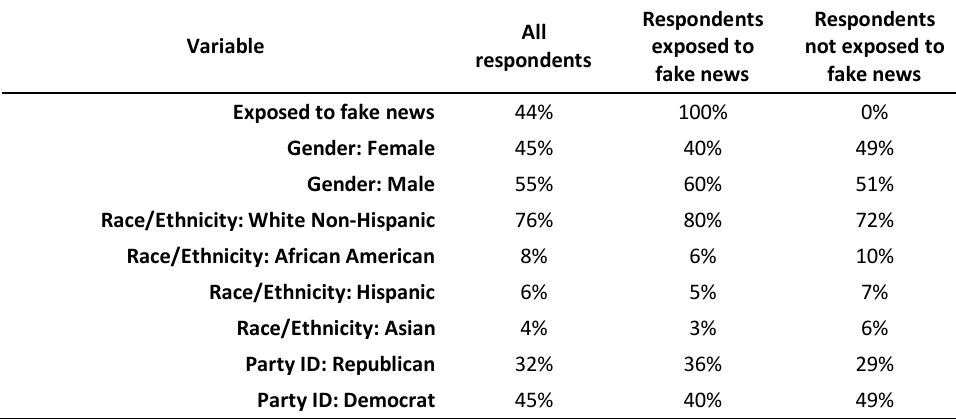
Table A1 . Demographic characteristics of the sample